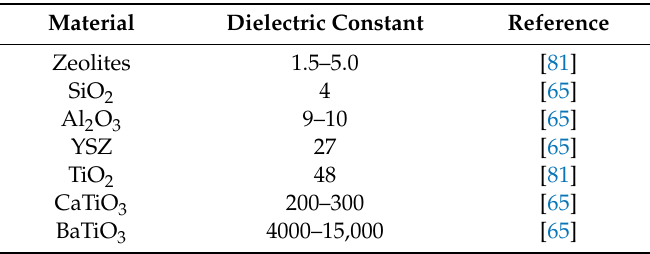
Table 5. Dielectric constant of typical